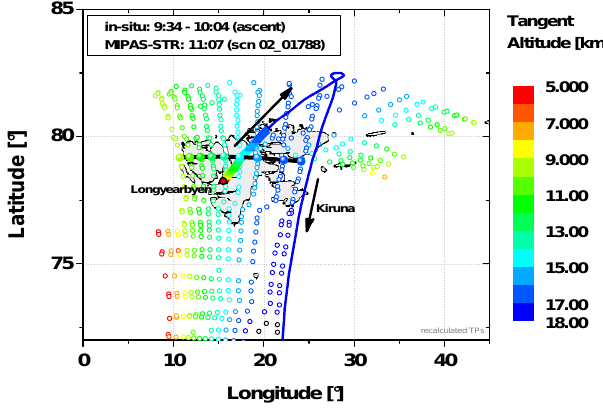
Fig. 14. Limb scan of MIPAS-STR selected for comparisons with in-situ profiles. The distribution of the tangent points of MIPAS- STR (circles) along the flight path (blue line) is indicated colour- coded with reference to the tangent altitude. The selected scan 02 01788 for the comparisons is indicated by filled circles. The flight path of the Geophysica is plotted colour-coded with altitude for the ascent